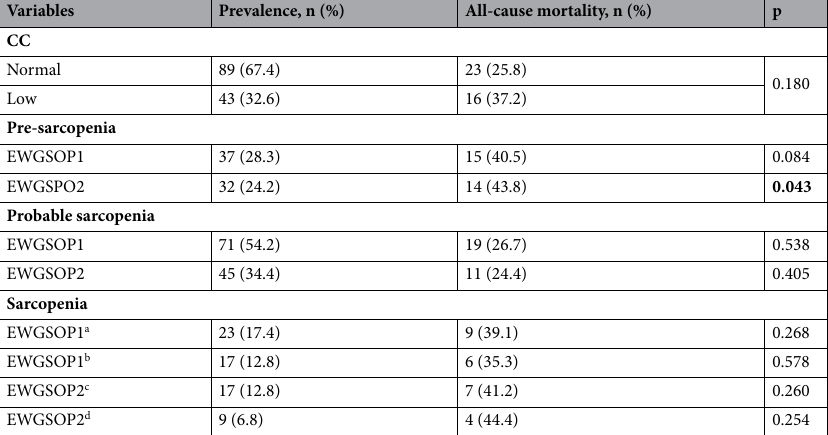
Table 2. Prevalence of sarcopenia, pre-sarcopenia and probable sarcopenia by the EWGSOP1 and EWGSOP2 criteria, two muscle mass assessment methods (n = 132) and association with all-cause mortality (n = 39). Statistical analysis: Chi-square test. CC calf circumference, EWGSOP European Working Group on Sarcopenia in older people, SD standard deviation. Significant values are in bold. EWGSOP1 a : Low Calf circumference + Low Handgrip strength. EWGSOP1 b : Low Skeletal muscle mass index + Low Handgrip strength. EWGSOP2 c : Low Handgrip strength + Low Calf circumference. EWGSOP2 d : Low Handgrip strength + Low Skeletal muscle mass index. *Missing data for 1 female participant.